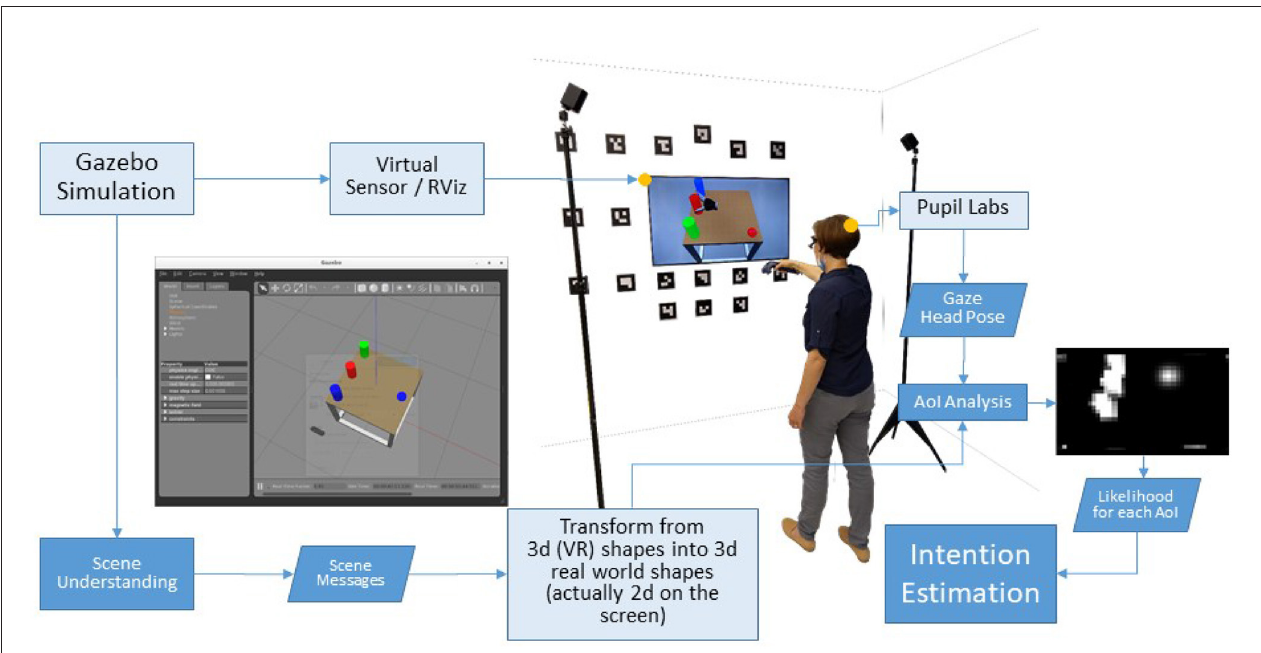
FIGURE 1 | The experiment was carried out in a simulated scenario. The Gazebo simulator features physics and a virtual sensor, with its measurements rendered on the screen. The user controls the Pick-and-Place-Task with a HTC Vive controller, tracked by the Vive Lighthouse system. At the same time, the Vive controller and a Pupil Labs eye-tracking system are used to estimate the human sensorimotor